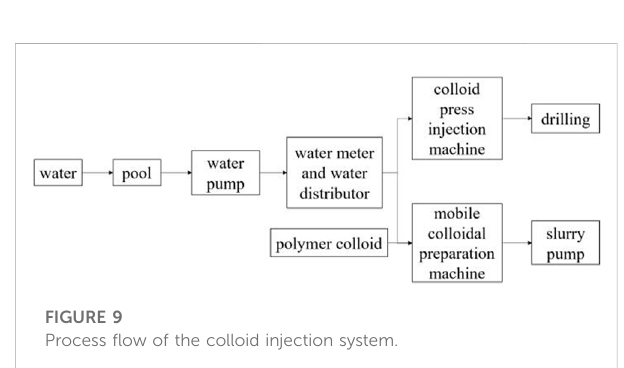
FIGURE 9 Process fl ow of the colloid injection